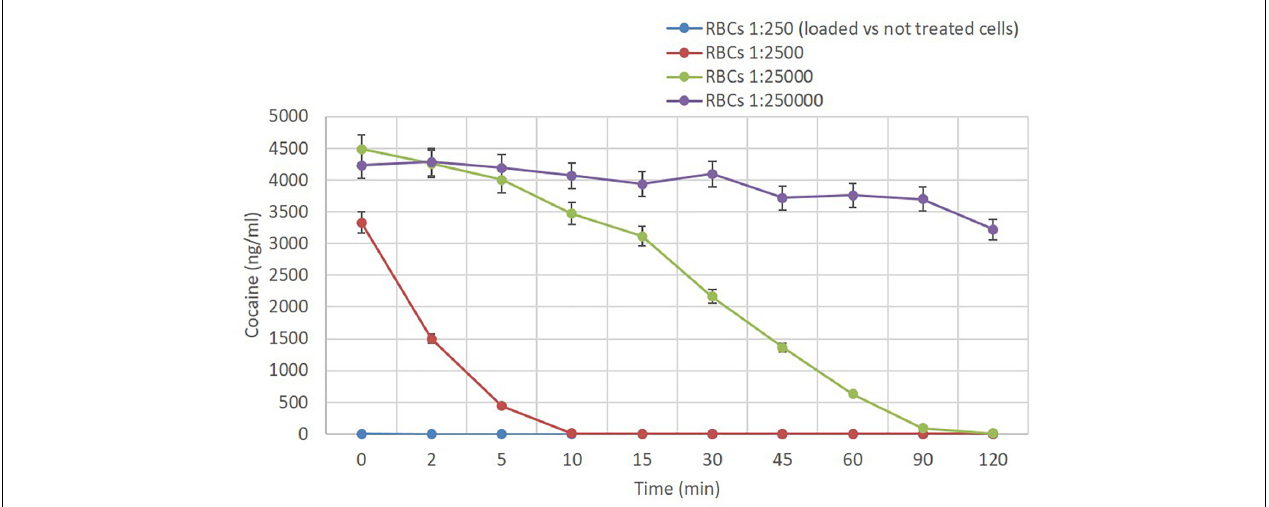
FIGURE 7 | Cocaine degradation. The ability of E196-301-loaded red blood cells (RBCs) to metabolize cocaine has been evaluated at different times (range 0–2 h) after incubation at 37 ◦ C in a 500 µ l-final volume with 5 µ g/ml cocaine concentration. Conditions: 0.28 IU E196-301/ml RBC suspension (blue); 0.028 IU E196-301/ml RBC suspension (red); 0.0028 IU E196-301/ml RBC suspension (green); 0.00028 IU E196-301/ml RBC suspension (violet). This is representative of two different duplicate experiments that agree within 5%. For the RBC condition 1:2500 the times 0, 2, 5, and 10 min are highly significant among them (****); for the RBC 1:25000 condition each time is significantly different from the previous one up to time point 90 min (***); for the RBC condition 1:250000 a significant difference has been observed at each time (with the exception of the time points 2, 5, and 30 min) with respect to time zero (by one-way ANOVA test, *** p < 0.001, **** p <